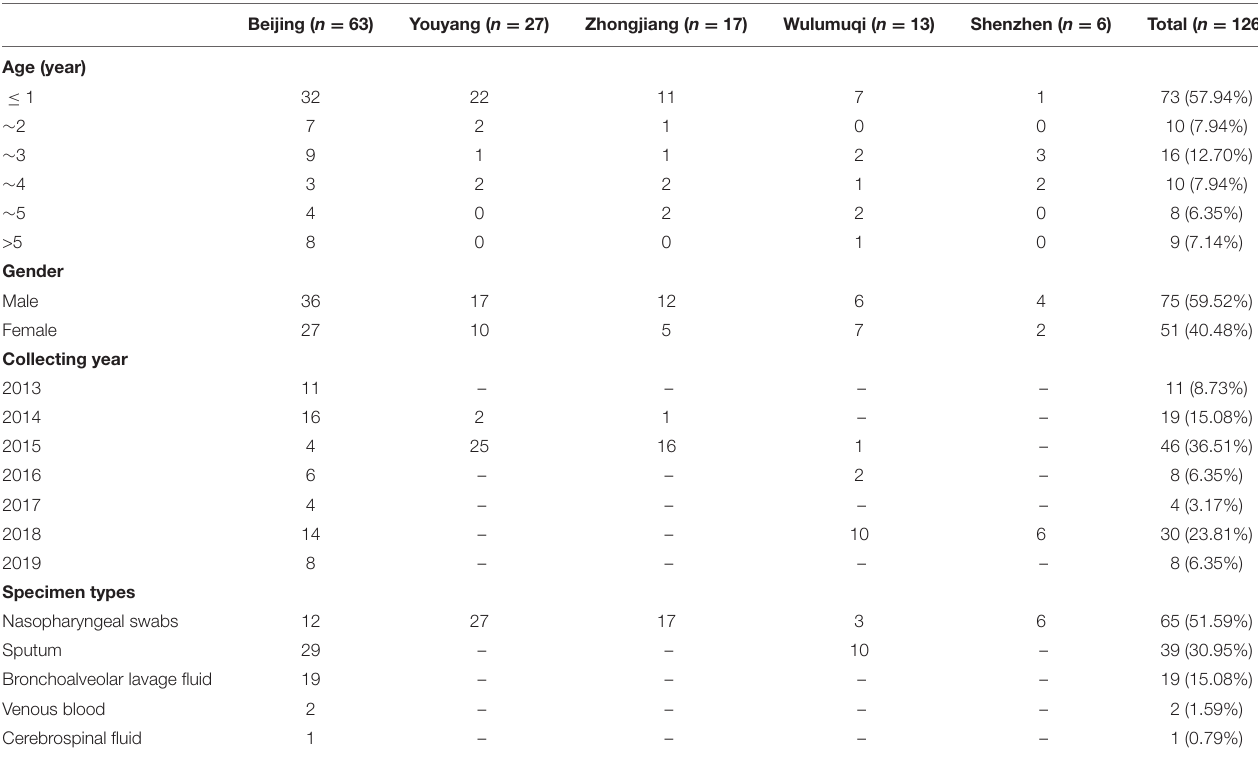
TABLE 1 | Clinical information on the strains included in this